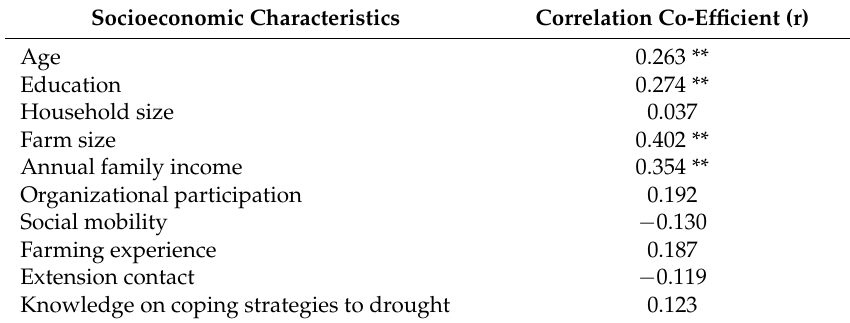
Table 4. Correlation between socioeconomic characteristics and coping strategies ( n =